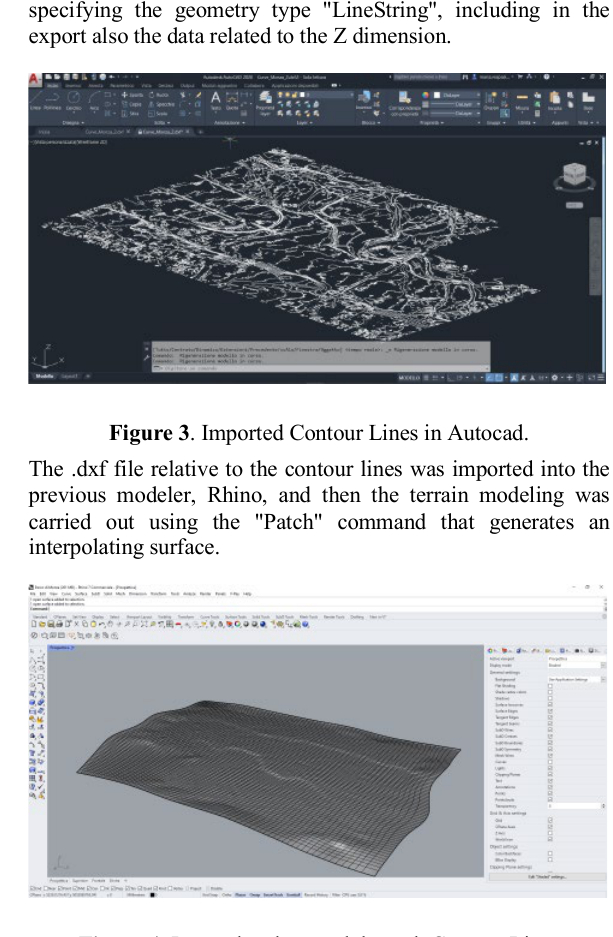
Figure 4 . Interpolated ground through Contour